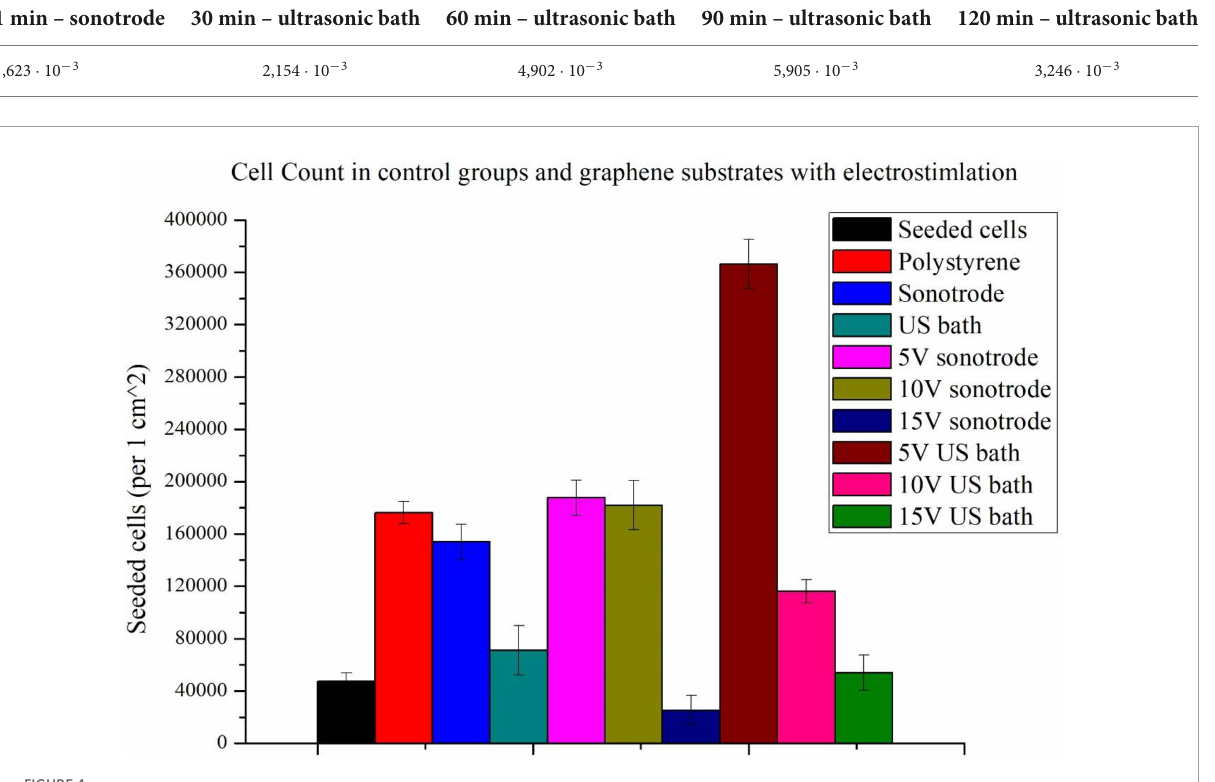
TABLE 4 Resistivity of the layers prepared using inks with different sonication times (1 min – sonotrode, 30, 60, 90, and 120 min ultrasonic bath). Resistivity ( (cid:127) · m)